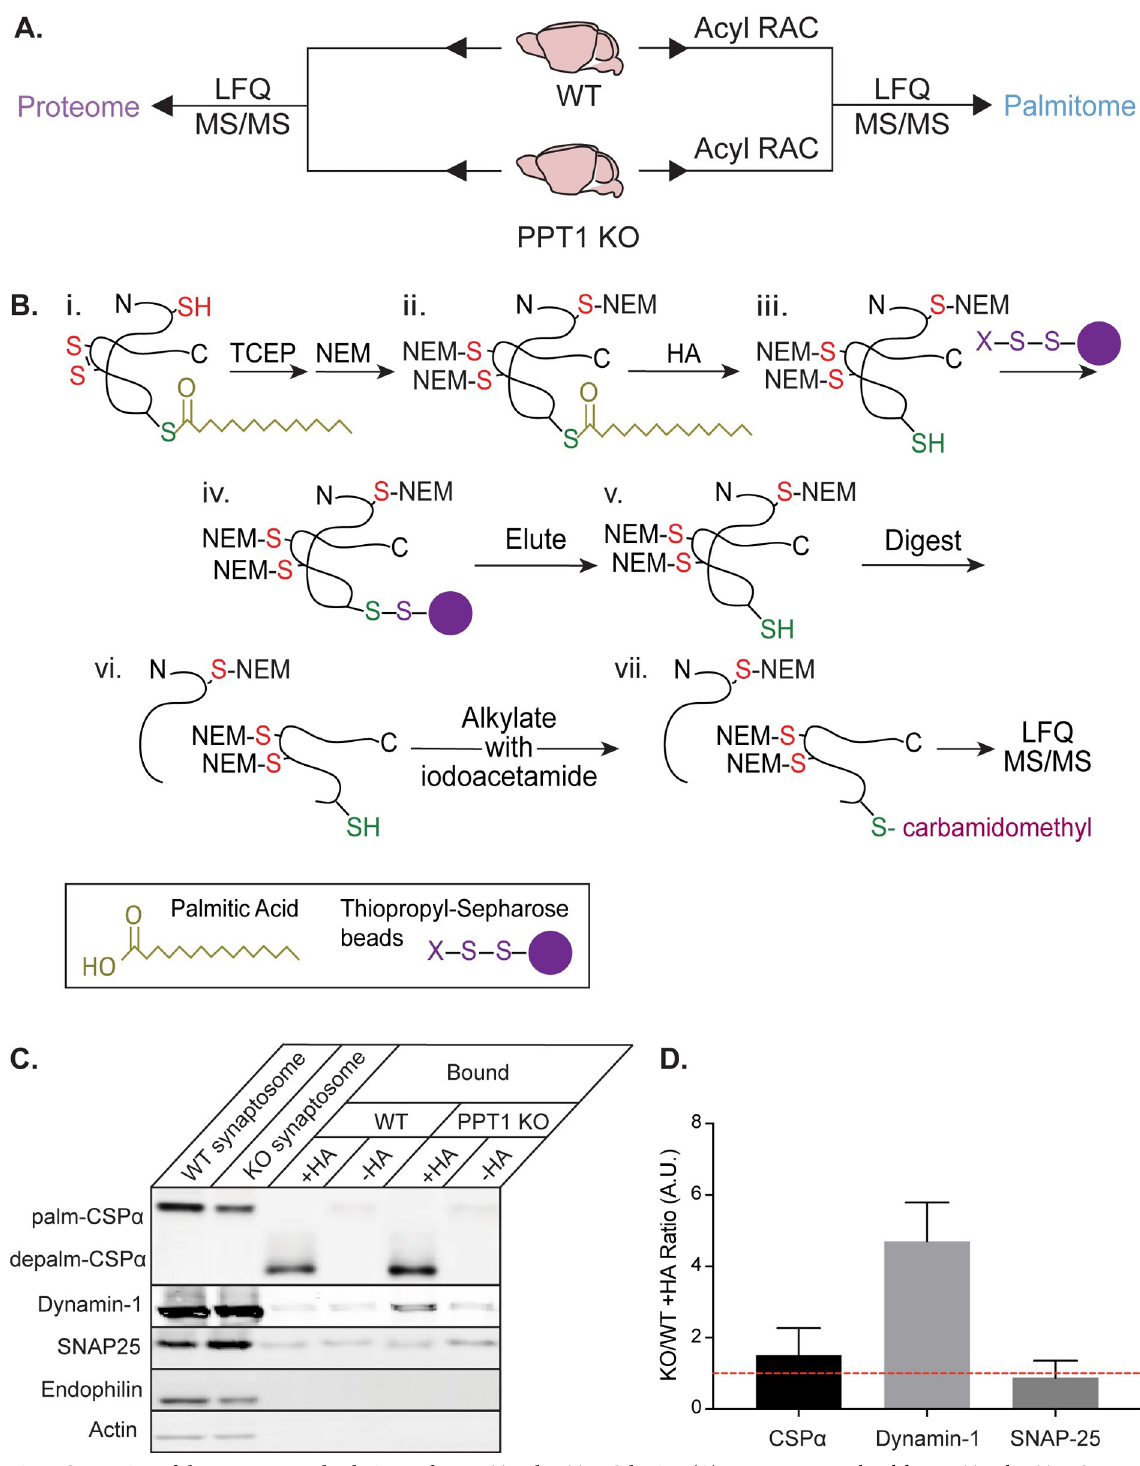
Fig 1. Generation of the proteome and palmitome from WT and PPT1 KO brains. (A) Proteins were isolated from WT and PPT1 KO whole brains or synaptosomes for proteomic analysis by LFQ-MS to identify overall protein expression (proteome; left) or following Acyl RAC to identify palmitoylated proteins (palmitome; right). (B) Schematic of Acyl RAC. (i) Disulfide bonds were reduced with TCEP and residual thiol groups were blocked with NEM. (ii) Palmitate groups were hydrolyzed with HA, leaving behind an unblocked free thiol. (iii) Free thiols were bound to thiopropyl sepharose beads, allowing for isolation of palmitoylated proteins. These proteins were then (iv) eluted from beads